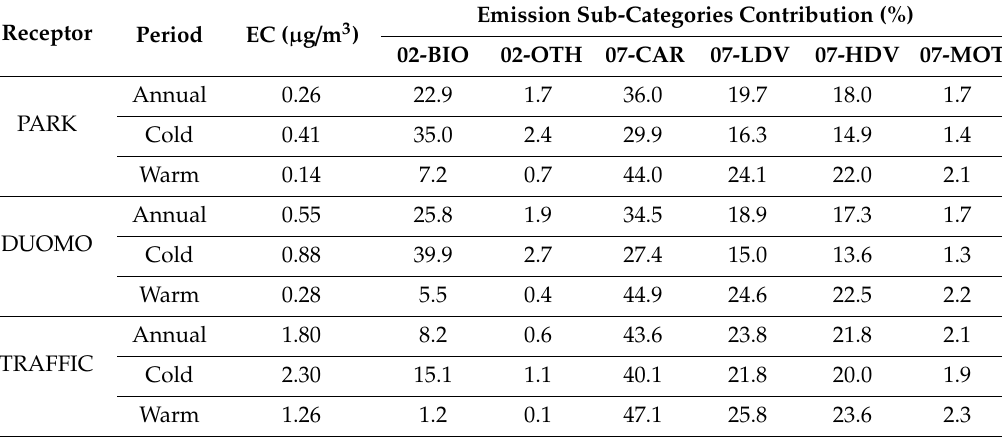
Table 2. Total annual and seasonal average contributions to EC ambient levels and percentage contributions of emission sources in the LOCAL area at the three urban receptors.